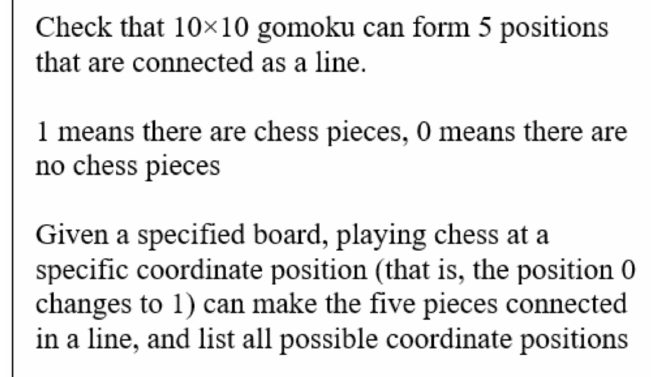
Figure 22. Test result after modifying program (3).